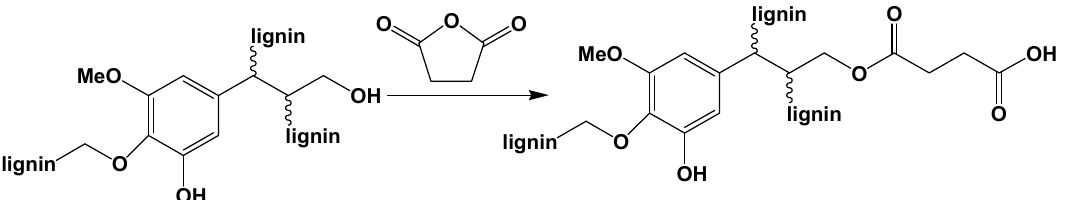
Figure 13. Schematic representation of the functionalization reaction between lignin and succinic anhydride (SAn) to produce succinylated lignin. Adapted from [65], with permission from American Chemical Society and Copyright Clearance Center, 2018.